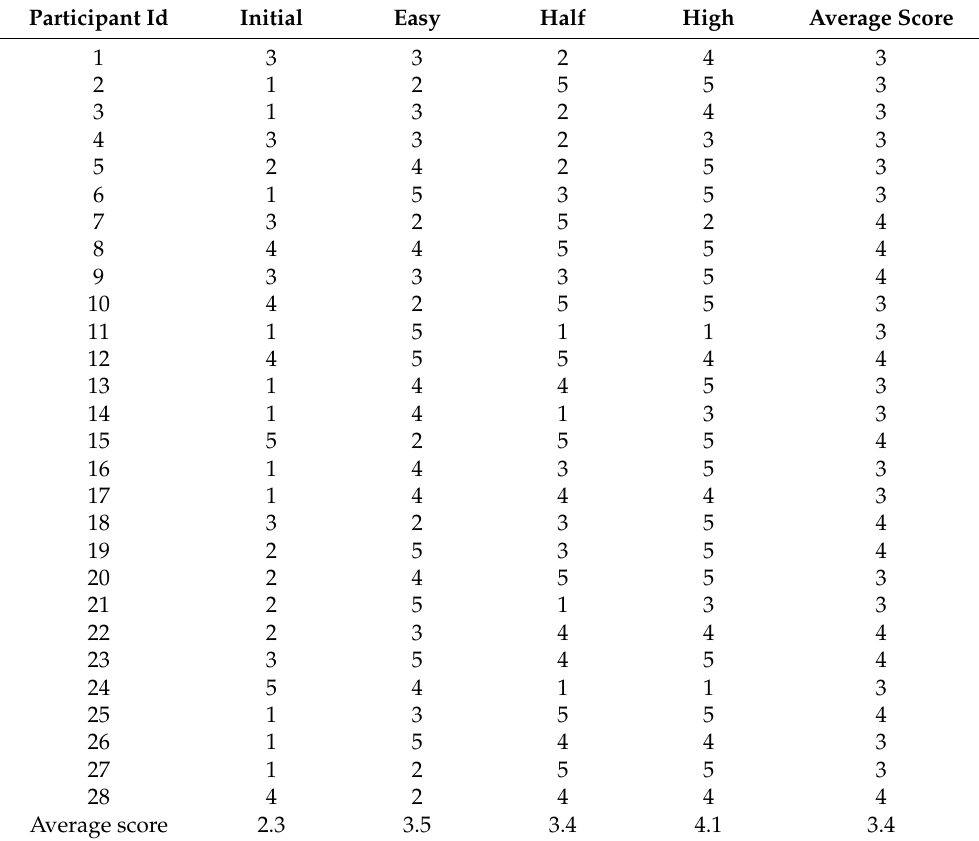
Table 5. Learning results obtained using questionnaires for each level. Participant